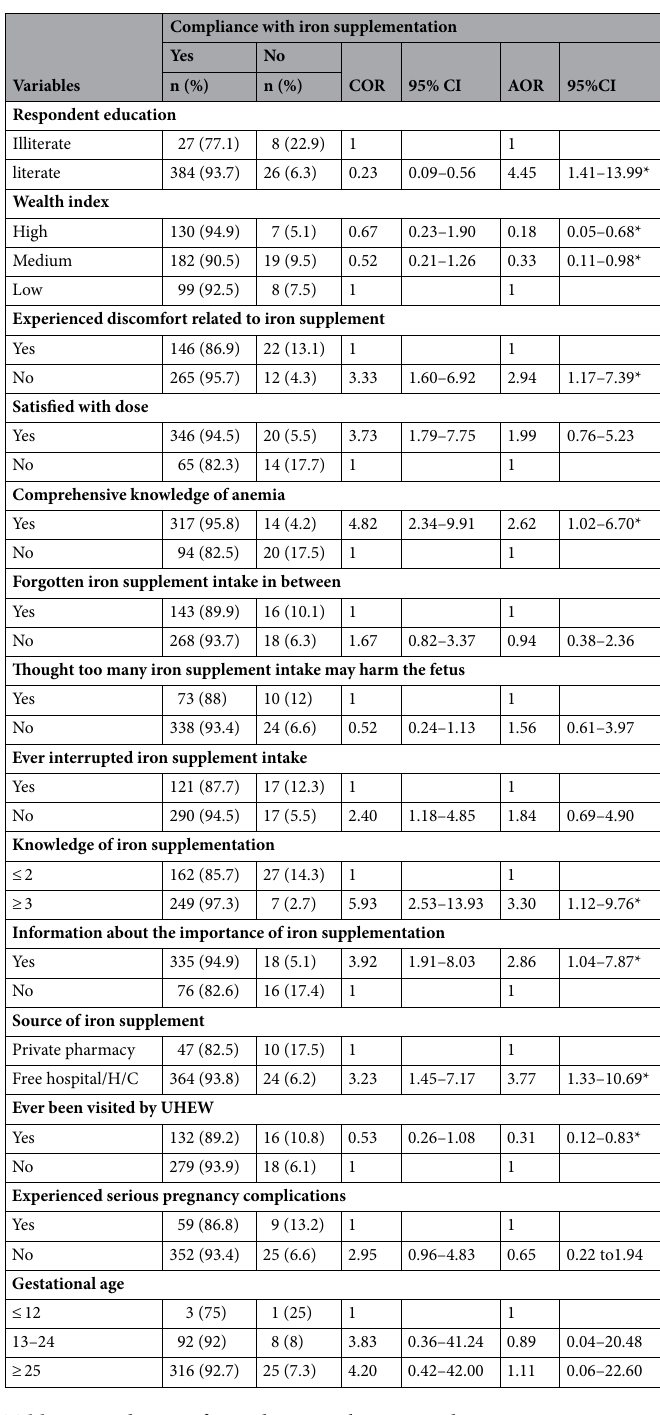
Table 2. Predictors of compliance with iron supplementation among pregnant women at Robe town, Bale Zone, Southeast Ethiopia, 2015 (n = 445). * Statistical significant association; COR Crude odds ratio, AOR Adjusted odds ratio, CI Confidence interval, 1 Reference category, UHCW Urban healthcare